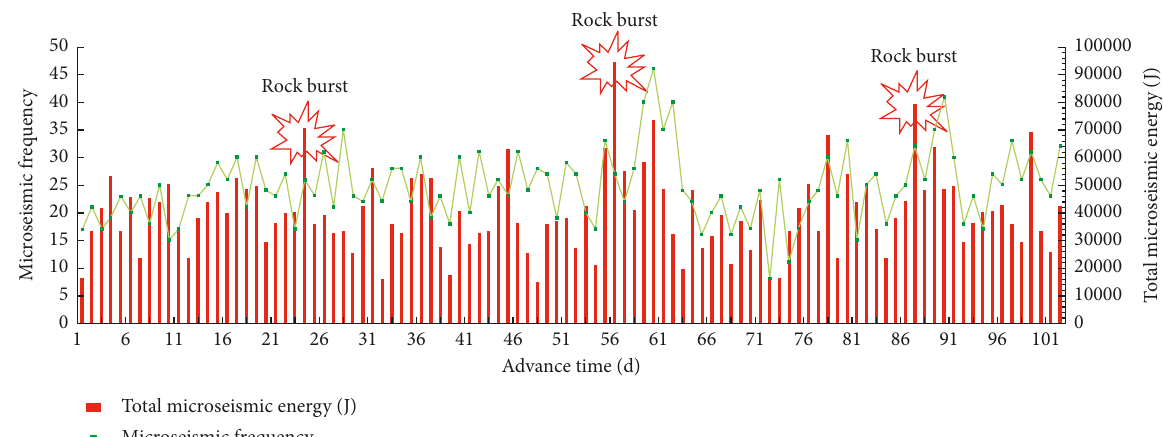
Figure 10: Total microseismic energy and microseismic frequency in mining process.